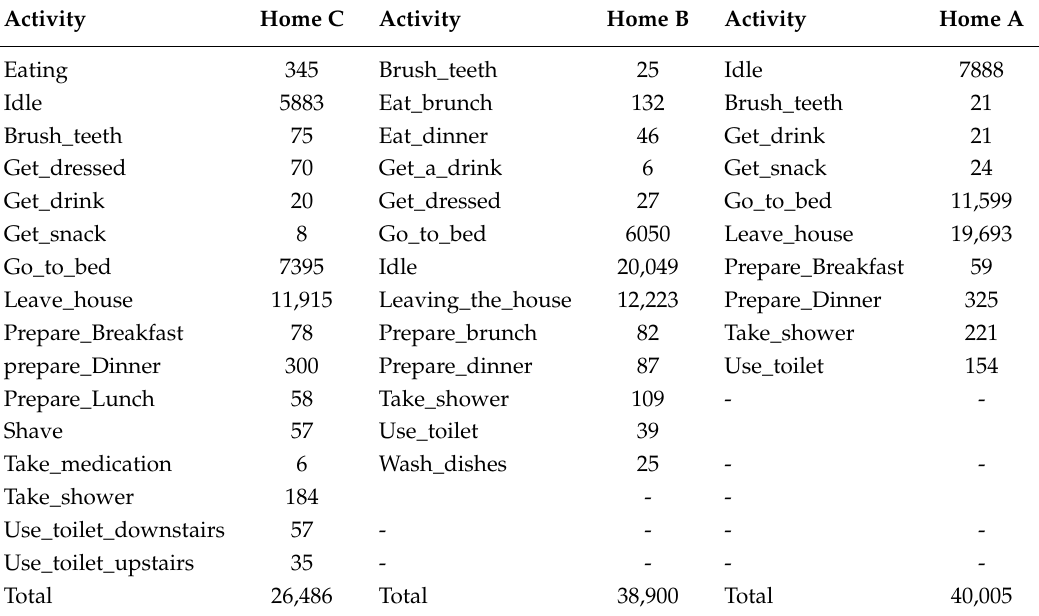
Table 3. Frequency of activities in the Kasteren